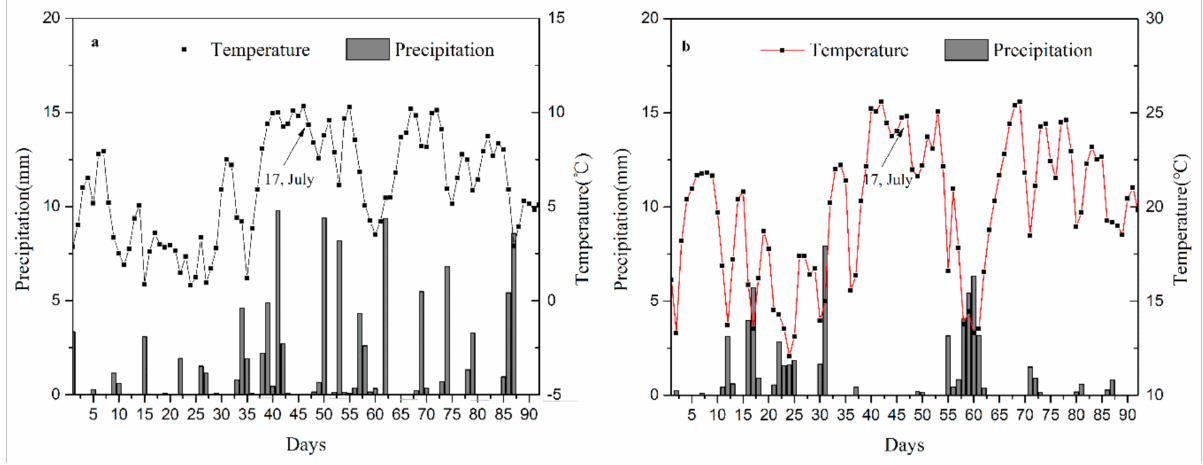
Figure 9. Temporal variations in temperature and precipitation from June to August 2018; ( a ) temperature and precipitation derived from reanalysis data; ( b ) temperature and precipitation derived from the AWS at the Ghukin